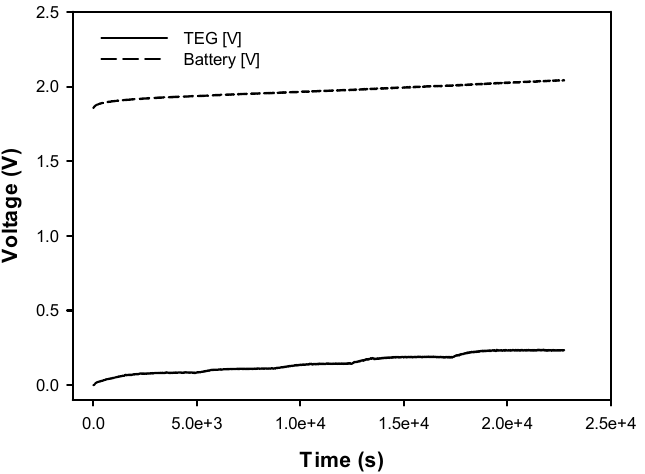
Figure 9. Voltage generated by TEG #1 and the voltage across the battery during a cold start situation using the TEG #1 + DC/DC converter #1 combination.